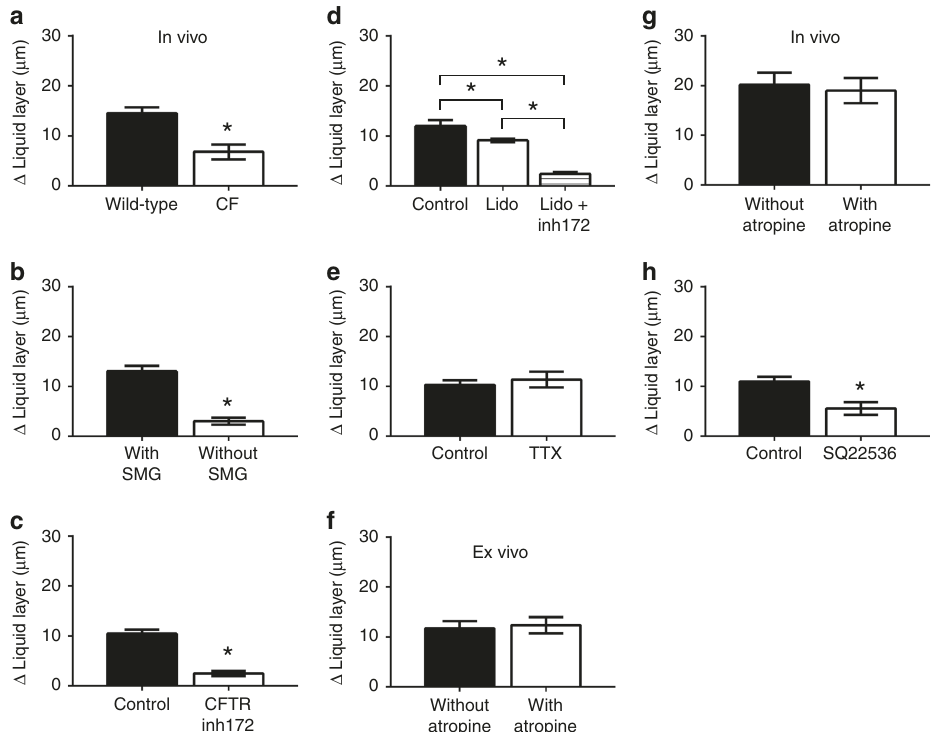
Fig. 4 CF tissues fail to produce basal ASL secretion. a CFTR − / − swine (CF, n = 9 from six animals) display lower basal ASL secretion than wild-type in vivo ( n = 10 from seven animals, mean ± SEM, P = 0.001, Mann – Whitney test). b Wild-type ex vivo preparations with surgically removed submucosal glands (SMG) produced lower basal ASL ( n = 12 with SMG from six preparations and n = 13 without SMG from six preparations, P < 0.0001, Mann – Whitney test). c Wild-type ex vivo preparations incubated with CFTRinh172 (100 µ M) produced lower basal ASL than non-treated preparations ( n = 6 from four preparations for control, and n = 14 from fi ve preparations for CFTRinh172, P < 0.0001, Mann – Whitney test). d Topical application of lidocaine (Lido) had a small effect on basal ASL secretion. Simultaneous treatment with the CFTR inhibitor (Lido + inh172) completely blocked basal ASL secretion ( n = 13 control from fi ve preparations, n = 21 Lido from eight preparations, and n = 16 Lido + inh172 from seven preparations; P < 0.0001, F (2, 47) = 59.35, ANOVA and Tukey ’ s multiple comparison test). e Tetrodotoxin (1 µ M, TTX) treatment had no effect on basal ASL secretion ( n = 18 control from eight preparations, and n = 11 TTX from four preparations, P = 0.58, Mann – Whitney test). Atropine had no effect on basal ASL secretion in f ex vivo preparations (10 µ M, n = 8 without atropine from three preparations and n = 8 with atropine from four preparations, P = 0.76, t = 0.30, df = 14, Student ’ s t test) or g in vivo wild-type swine (treated with 0.04 mg/kg IM 2 – 10 min following induction of anesthesia, n = 8 without Atropine from six animals, and n = 10 with Atropine from seven animals, P = 0.75, t = 0.32, df = 16, Student ’ s t test). h Treatment with SQ22536 (0.5 mM) blocked ASL secretion ( n = 10 control from four preparations and n = 11 SQ22536 from four preparations; P = 0.0003, Mann – Whitney test). Data is presented as mean ± SEM and within each panel the columns labeled with an asterisk differ signi fi